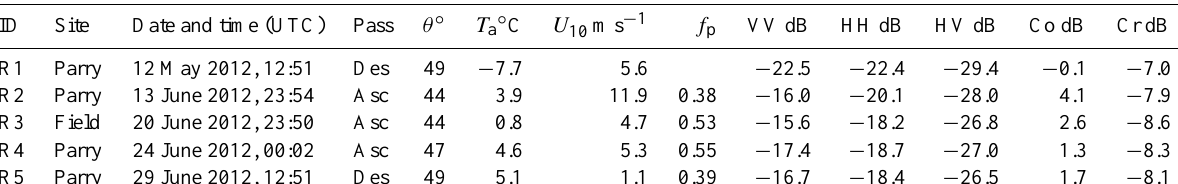
Table 1. Radarsat-2 scene characteristics, pass (Ascending - Asc or Descending - Des) coincident hourly air temperature ( T a ) and wind speed ( U 10 ) recorded at Resolute Airport, study area f p from aerial survey data, and HH, VV, HV, VV / HH (Co) and HV / HH (Cr) backscatter after SAR processing.